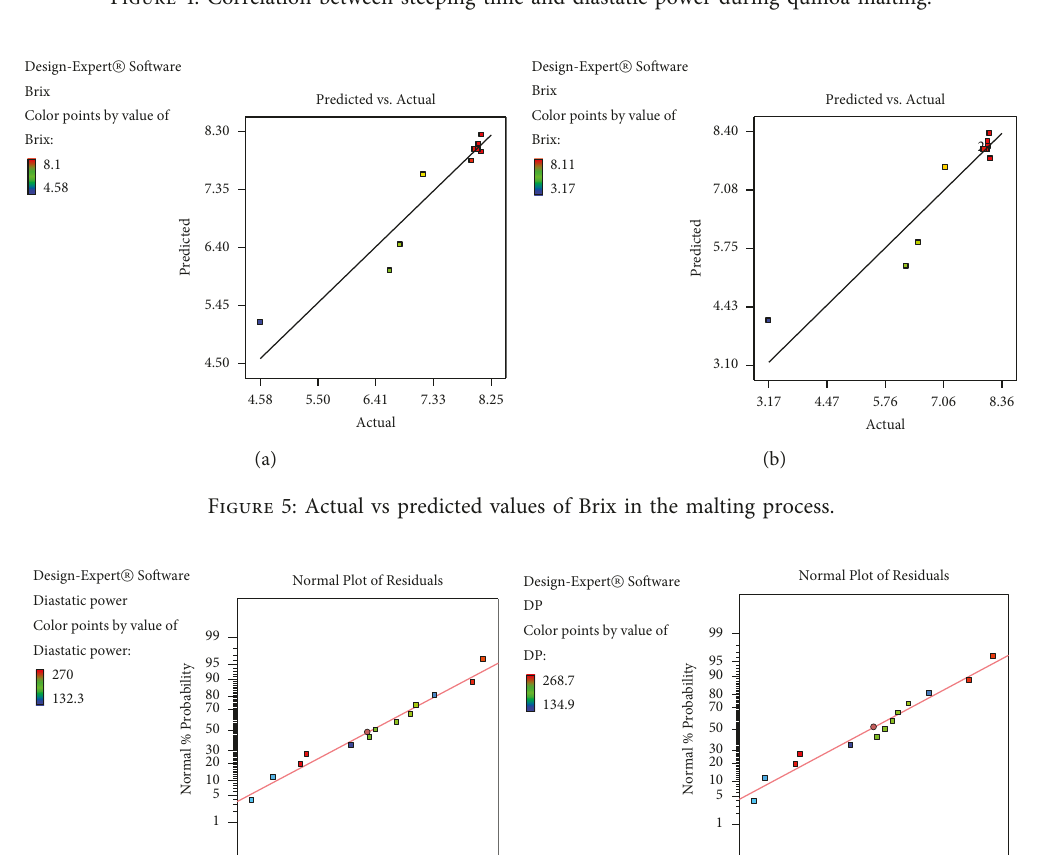
Figure 4: Correlation between steeping time and diastatic power during quinoa malting.